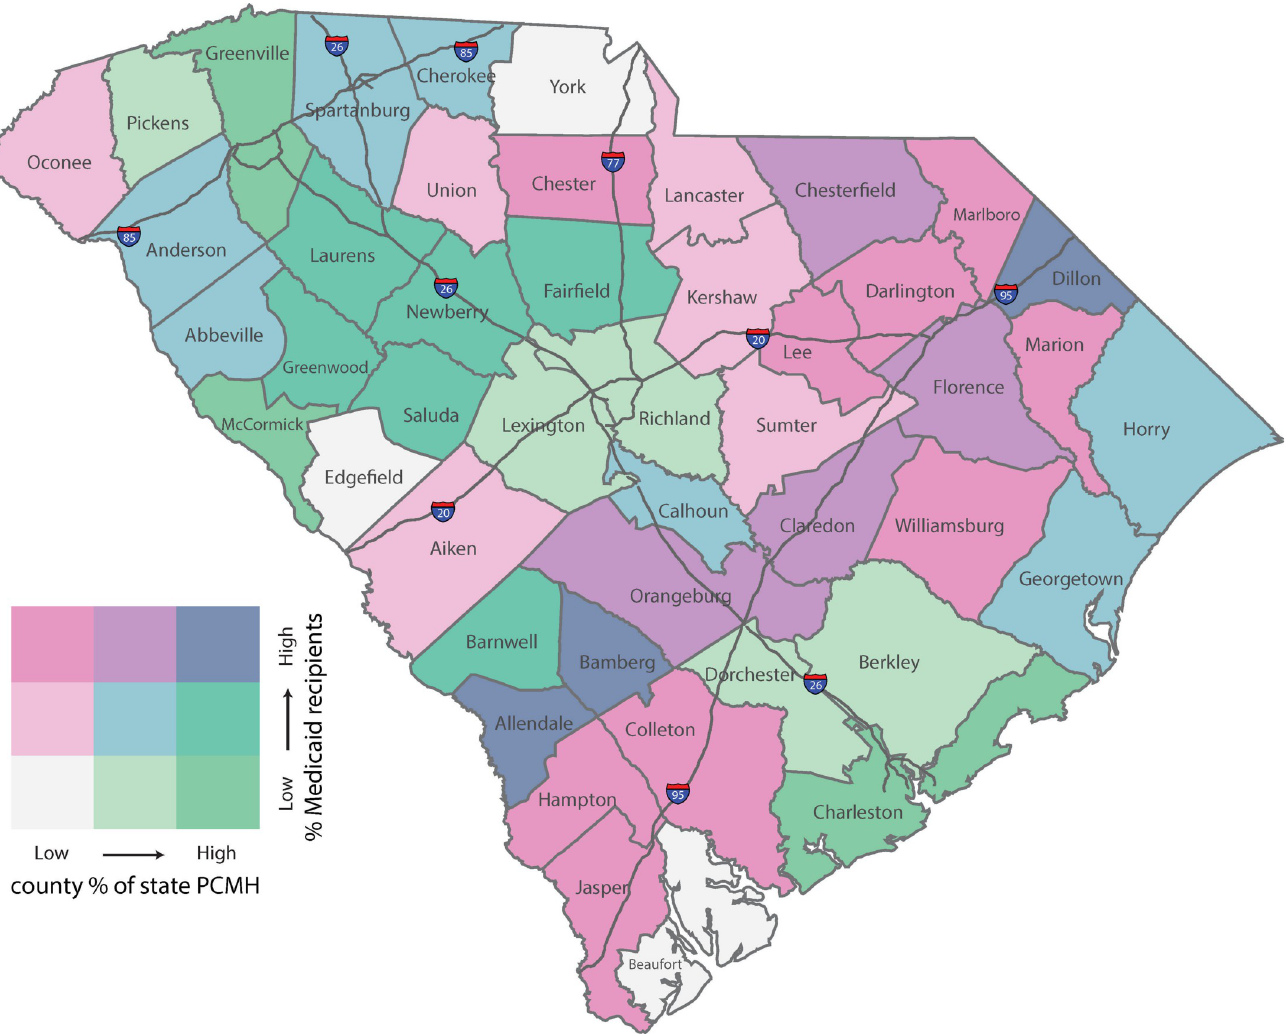
Fig 1. Bivariate choropleth map of county proportion of medical homes relative to all primary care providers and the proportion of county population enrolled in Medicaid. Figure created by the authors using the University of South Carolina’s site license for ArcMap. Data to recreate the map is publicly available through the American Community Survey, the NPI Certification files distributed by the Centers for Medicare and Medicaid Services, and the NCQA data feed file (NCQA data available through subscription).